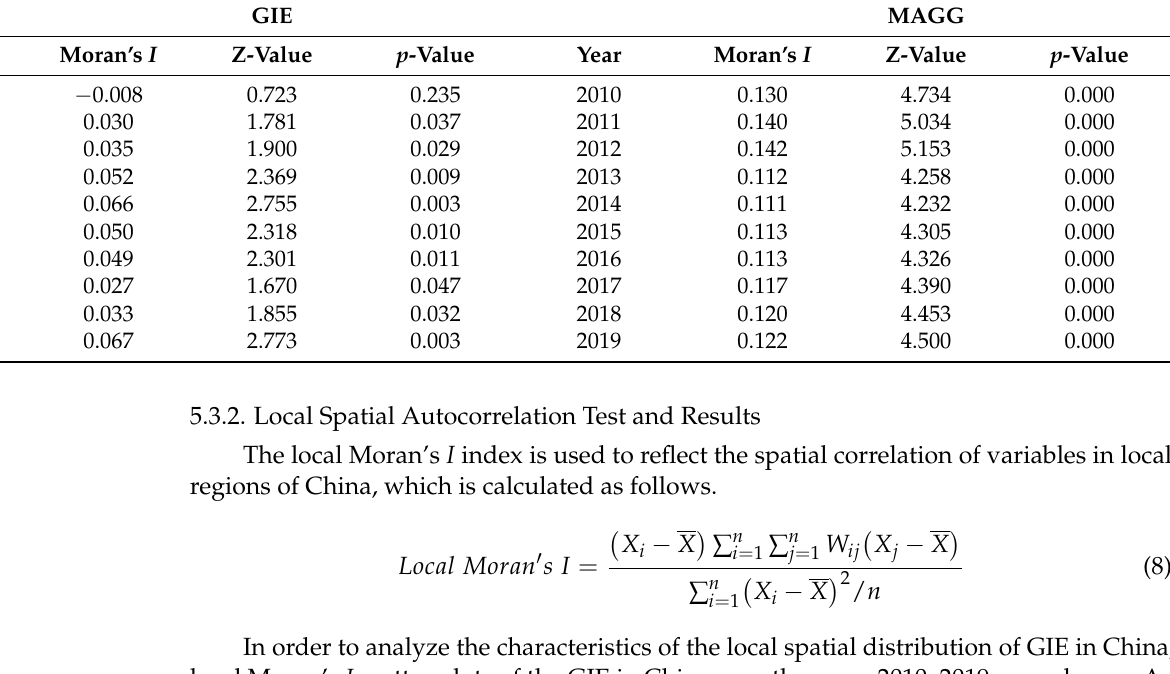
In order to analyze the characteristics of the local spatial distribution of GIE in China, local Moran’s I scatter plots of the GIE in China over the years 2010–2019 were drawn. As indicated in Figure 7, most provinces (autonomous regions and municipalities) are located within quadrants one and three, which again proves that there is a positive spatial correla- tion between GIE in each region. Specifically, Beijing, Tianjin, Jiangsu, and Guangdong are always located in the first quadrant, indicating a high-high (HH) agglomeration. With the passage of time, the number of provinces (autonomous regions and municipalities) in the first quadrant increases, especially those in the Yangtze River Delta and Pearl River Delta regions in eastern China, while the provinces (autonomous regions and municipalities) are central and western China is mainly in the third quadrant of low–low (LL) agglomeration. A strong local spatial agglomeration effect of GIE is revealed.